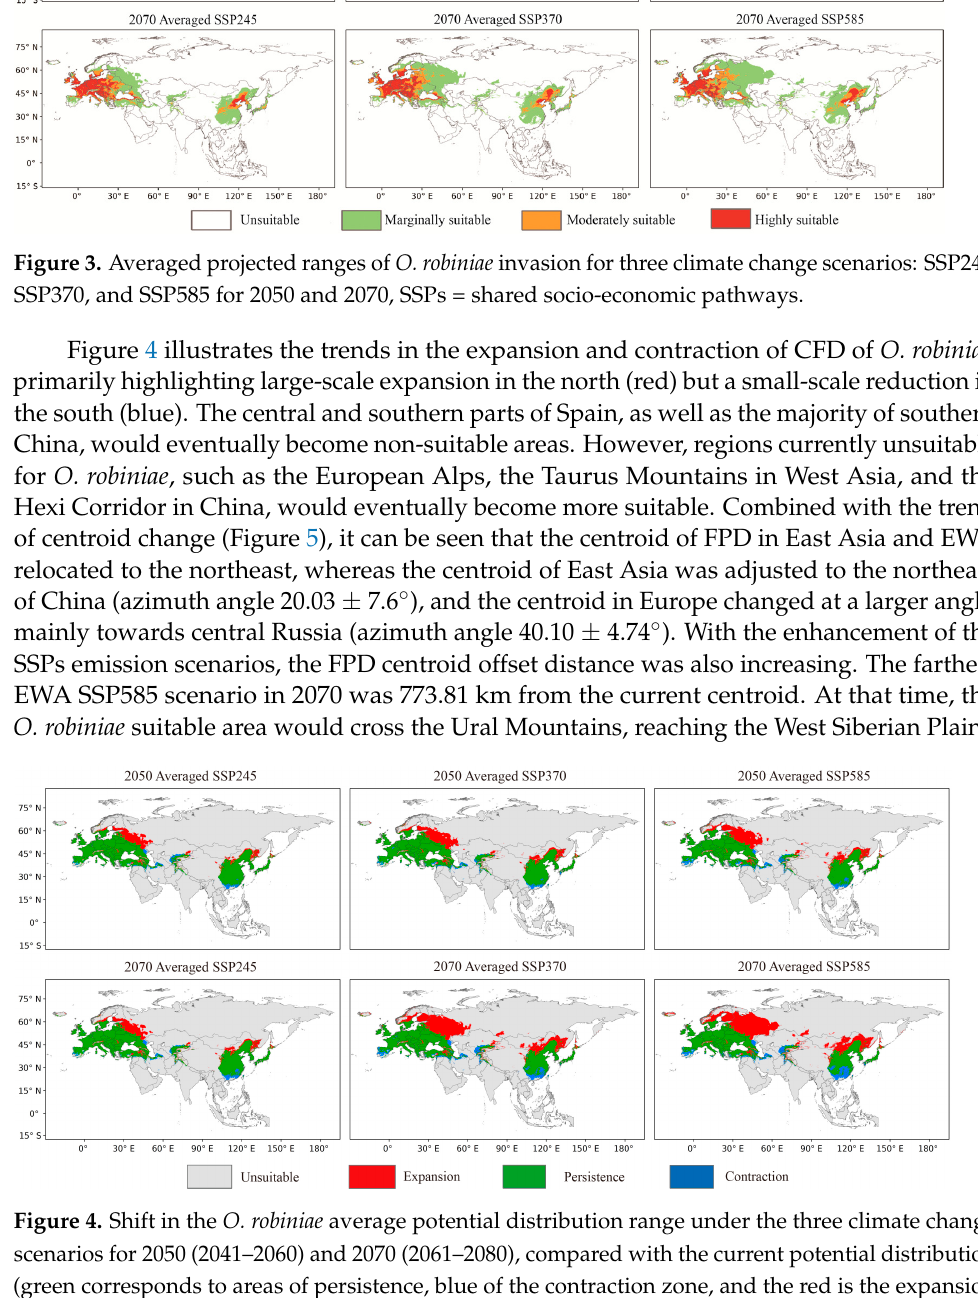
Figure 2. Predicted suitable areas for O. robiniae under present and future climatic conditions (km 2 ) and percentage (%) of increase/decrease (compared to the currently suitable areas).